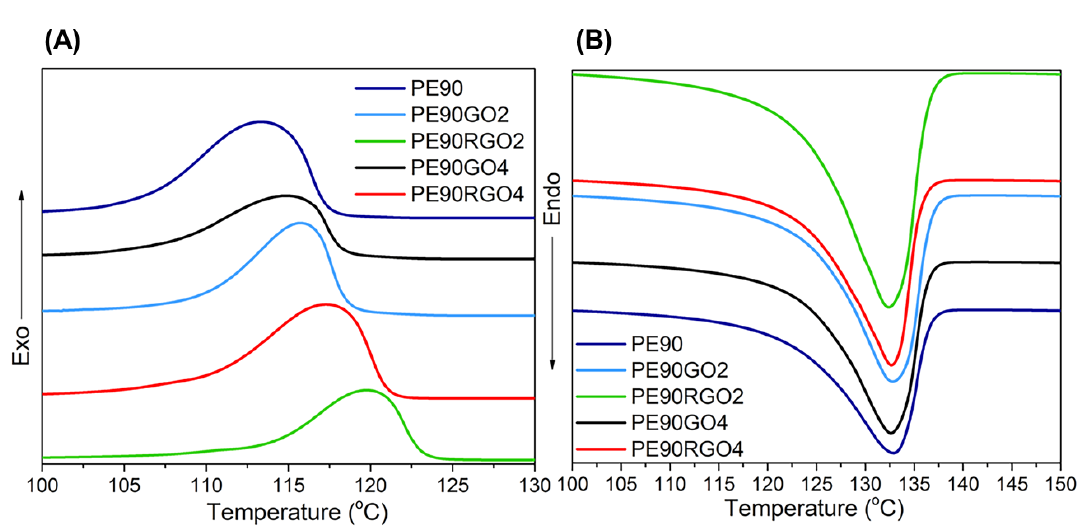
Figure 7. Cooling ( A ) and heating ( B ) thermograms of PE in unfilled and filled binary systems.